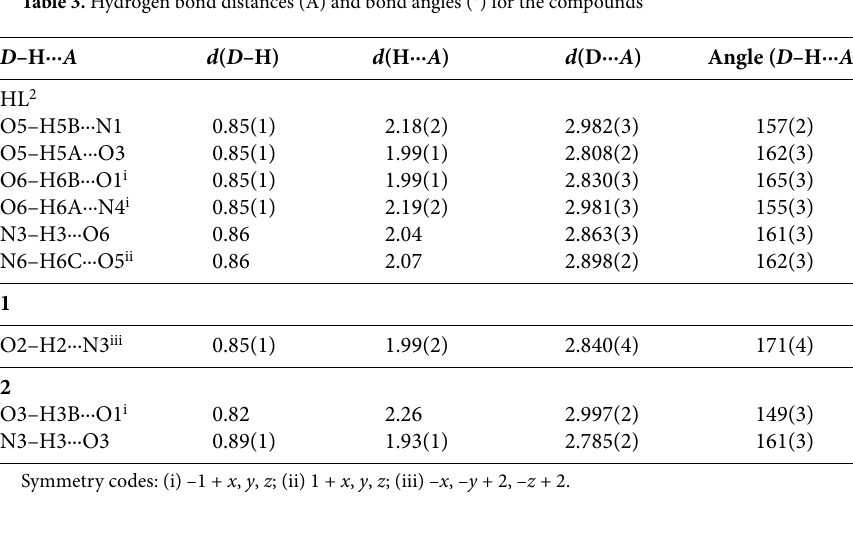
Table 3. Hydrogen bond distances (Å) and bond angles (°) for the compounds